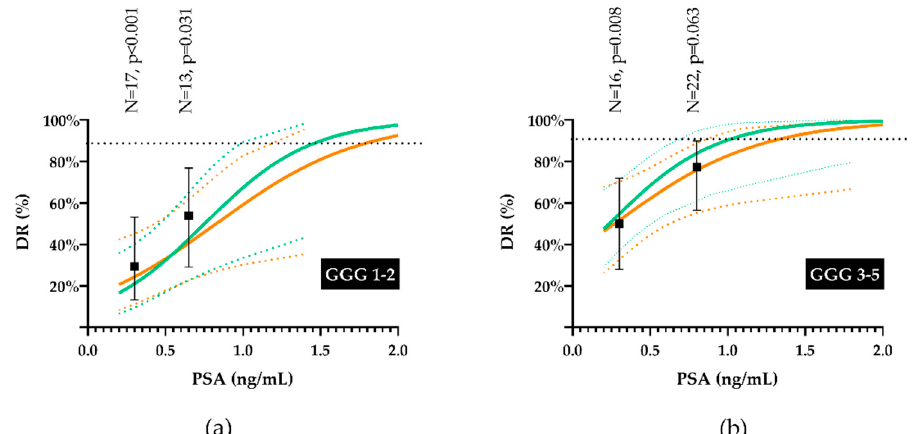
Figure 5. Estimated DR according to the logistic function for PSMA PET/CT by Gleason Grade Group (GGG): GGG 1-2 ( a ) and GGG 3-5 ( b ). The green continuous and the orange continuous lines correspond to individual weighted PSA and total serum PSA, respectively. Dashed lines identify the 95% confidence intervals of the logistic function. The horizontal dashed black line is the lower 95%CI of DR at mpMR. The black dots (and 95%CI bars) correspond to the observed DR after stratification of nodules by median iwPSA.